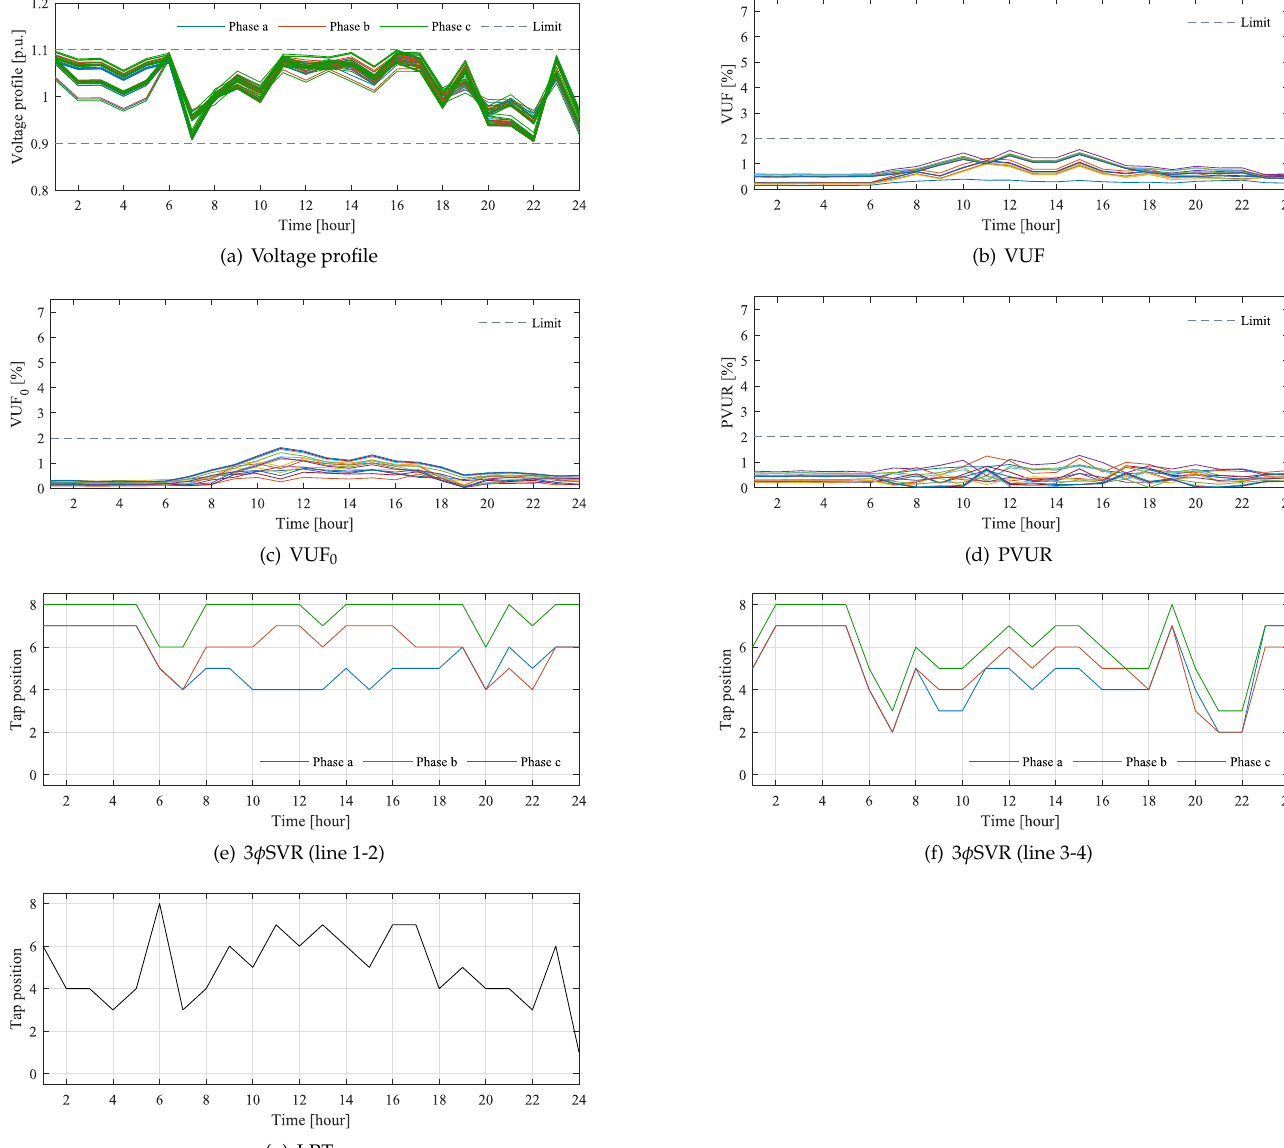
Figure 6. Simulation result of Case 2: minimize sum of all voltage unbalance metrics; the different colors in ( b – d ) refer to different buses. All unbalance metrics are less than 2% for all-day.